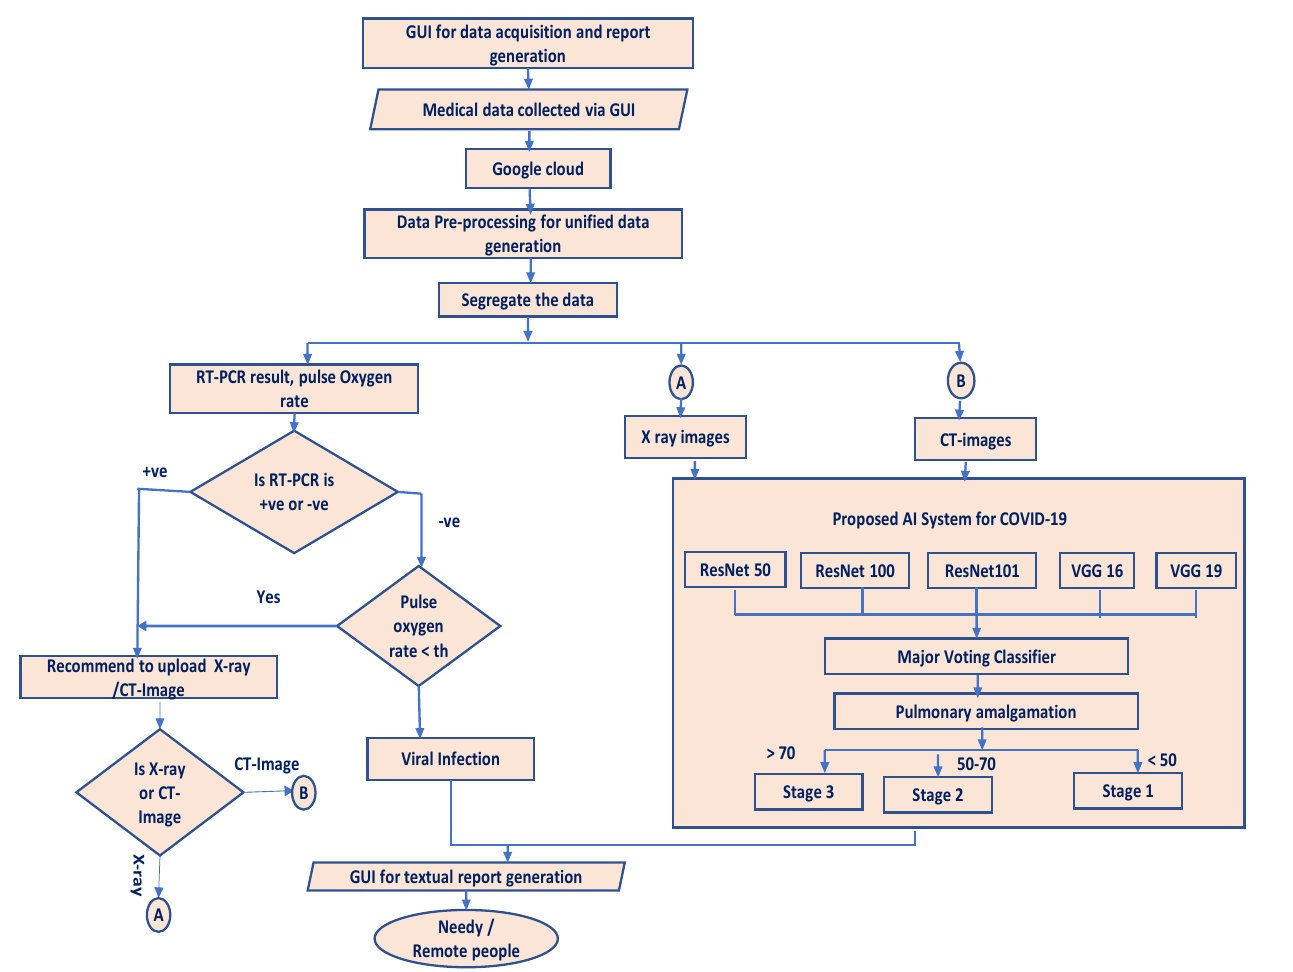
Figure 3. Workflow of the proposed IoMT Treatment Support System for COVID–19.